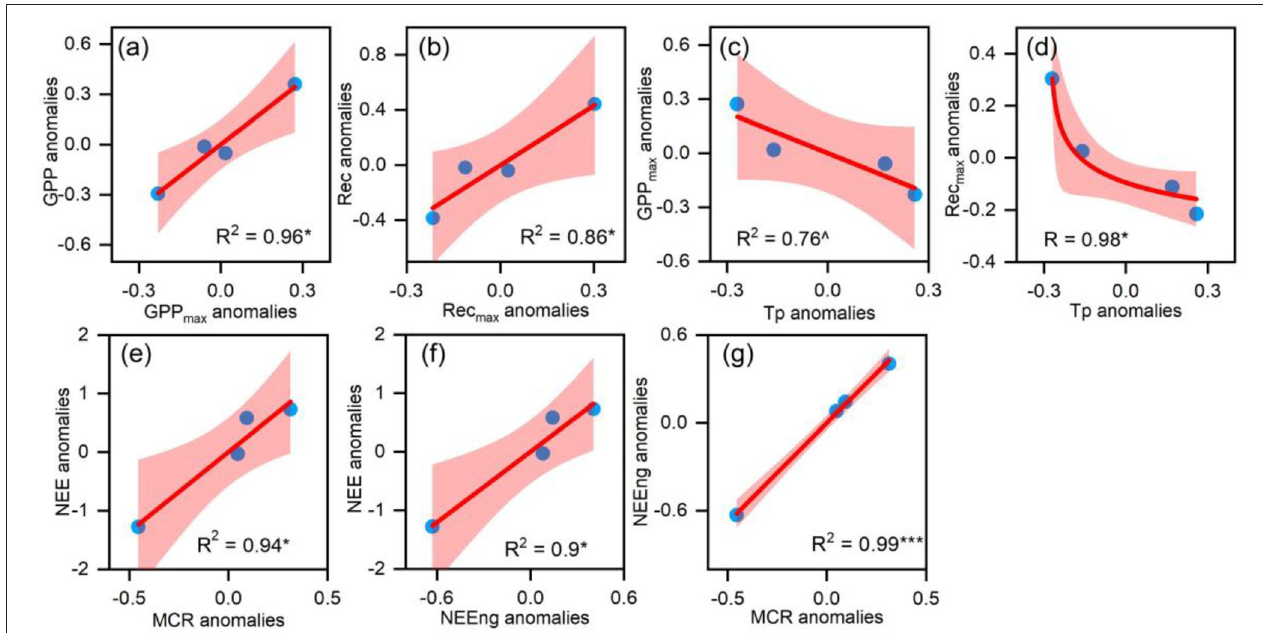
FIGURE 6 | (a) The relationship between the yearly gross primary productivity (GPP) anomalies and the GPP max anomalies; (b) the relationship between the yearly Re anomalies and the Re max anomalies; (c,d) the relationship between the GPP max anomalies, the Re max anomalies, and the preseason temperature (Tp) anomalies and; (e–g) the relationship between the MCR anomalies, the NEE ng anomalies, and the NEE anomalies. ∧ when p < 0.1, * when p < 0.05, ** when p < 0.01, ***when p < 0.001.